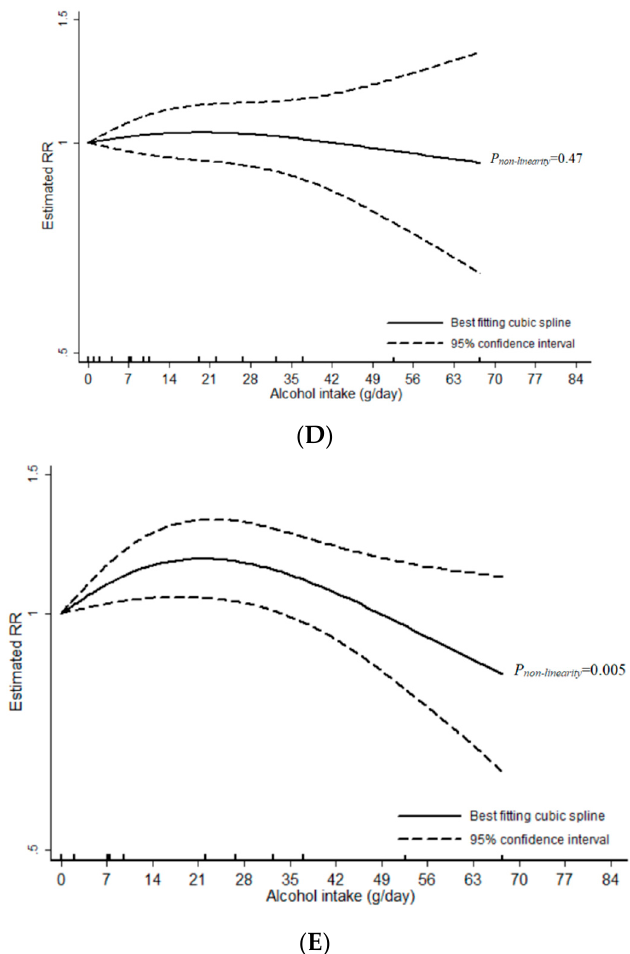
Figure 5. Meta-analyses of liquor intake and prostate cancer risk: ( A ) linear analysis with non-aggressive PCa; ( B ) non-linear analysis with non-aggressive PCa; ( C ) linear analysis with aggressive PCa; ( D ) non-linear analysis with aggressive PCa; ( E ) non-linear analysis with aggressive PCa (Sensitivity). Abbreviations: PCa, prostate cancer; RR, relative risk; CI, confidence interval.